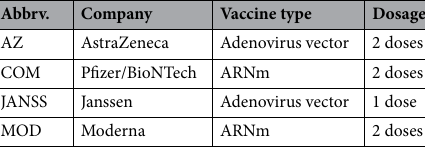
Table 1. Vaccines authorized by the EMA.